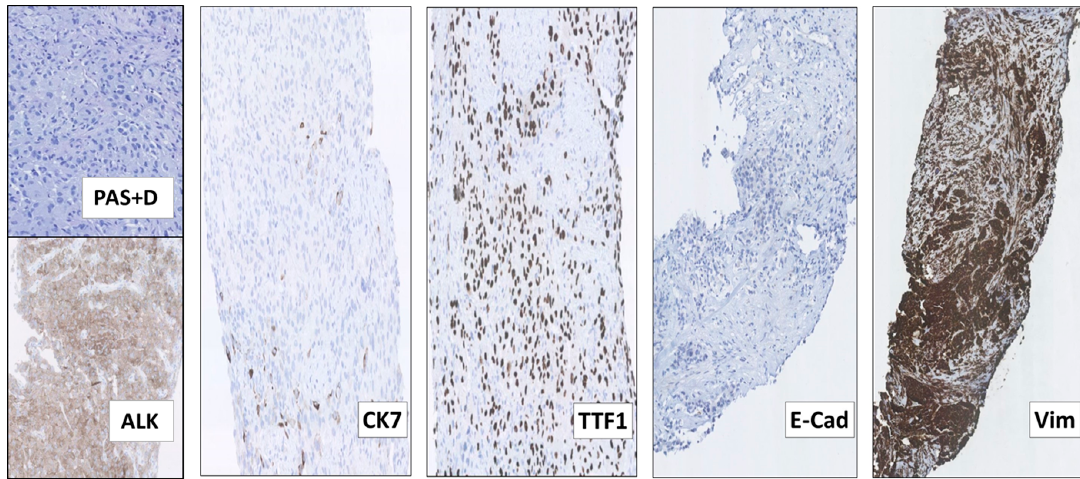
Figure 3. The 4th rebiopsy from the retroperitoneal NSCLC metastasis at progression after re-challenge with Alectinib, displaying features of epithelial-mesenchymal transition (EMT). Although many of the metastatic NSCLC cells had become more spindle-shaped and did not display any production of periodic acid–Schiff-positive diastase-resistant mucin (PAS+D), they still expressed the ALK fusion-protein (ALK). Most of the tumor cells had also lost the expression of the adenocarcinoma marker CK7, but maintained that of TTF1, consistent with their pulmonary origin. Moreover, the metastatic cells completely lacked the expression of the epithelial marker E-Cadherin (E-Cad) and had acquired that of the mesenchymal marker Vimentin (Vim), consistent with EMT. (All images: original magnification 100× except Vim 63×).